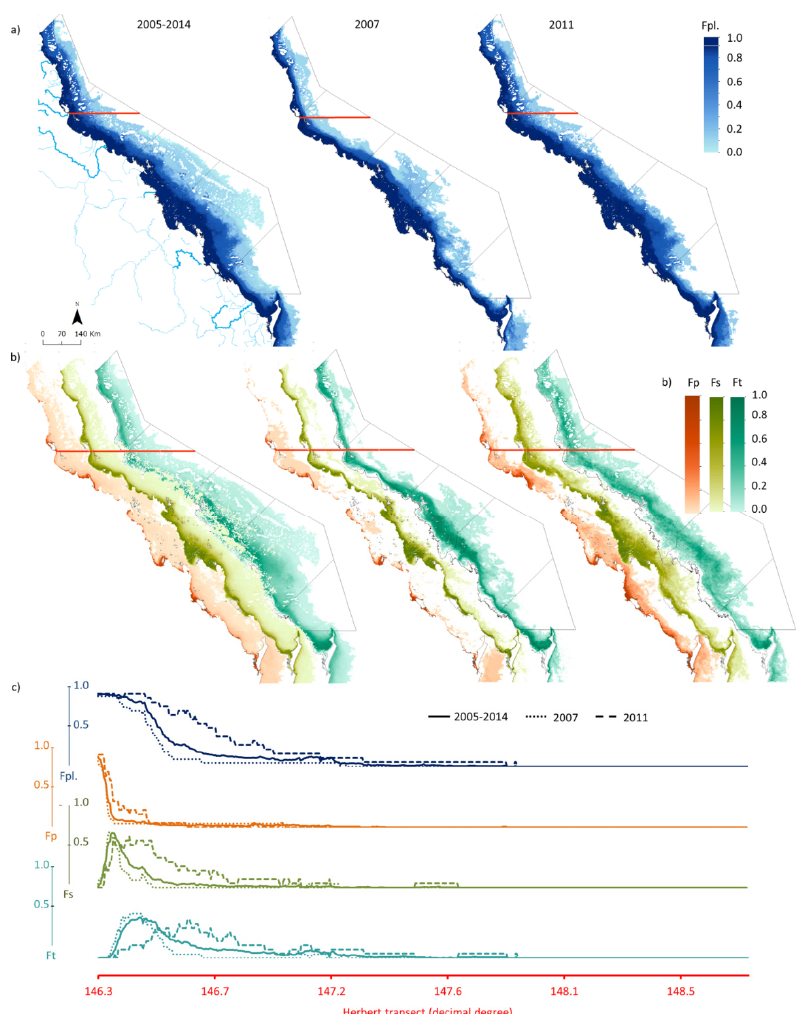
Figure 5. Multi-annual (2005–2014), 2007 (low flow wet season) and 2011(high flow wet season) ( a ) plume frequency (Fpl.); ( b ) plume water type composite maps (Primary: Fp, Secondary: Fs, Tertiary:Ft); and ( c ) extracted frequency values (Fpl., Fp,Fs, Ft) along a notional transect from the mouth of the Herbert River.